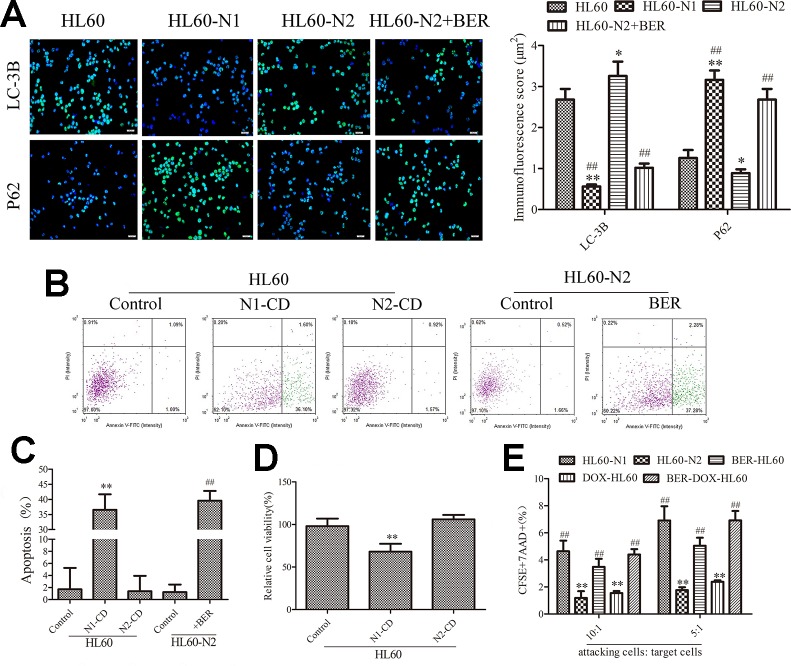
N1-like and N2-like neutrophils had different effects on HL-60 cells. (A) Cell autophagy as indicated by LC-3B and P62 staining (n = 5, 40×). (B, C) and (C) Cell apoptosis detected by the Annexin V-FITC apoptosis kit (n = 5). (D) HL-60 cell viability detected by 3-(4,5-dimethylthiazol-2-yl)-2,5-diphenyltetrazolium bromide (MTT) assay (n = 5). (E) Cytolytic activity (n = 5). The data present mean ± SD, the experiments were repeated three times, and statistical significance was determined by a t-test. (A, C, D) *P < 0.05, **P < 0.01 vs. HL60; ##P < 0.01 vs. HL60-N2. (E) *P < 0.05, **P < 0.01 vs. HL60-N1; ##P < 0.01 vs. HL60-N2. DOX, doxorubicin; BER, berberine.